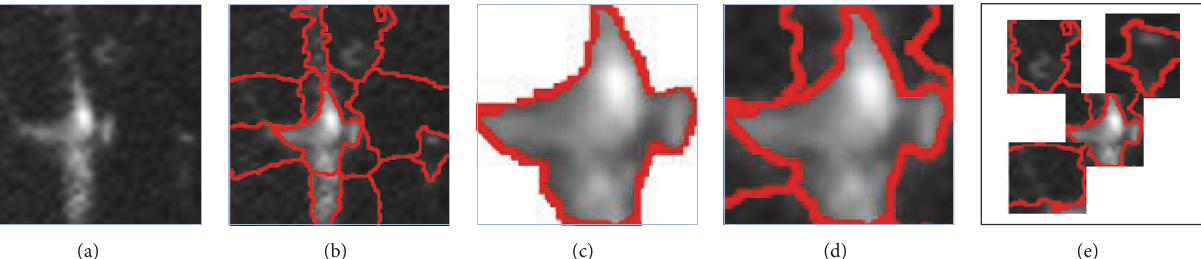
Figure 3: The process of local patch generation by Superpixel.